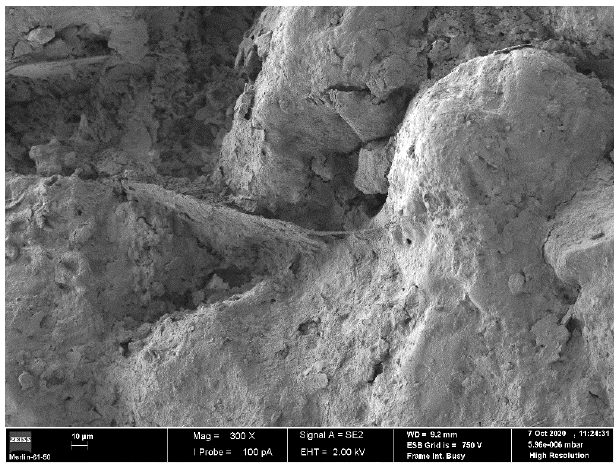
Figure 8. SEM image of the mixture produced with the commercial XG at 300×.